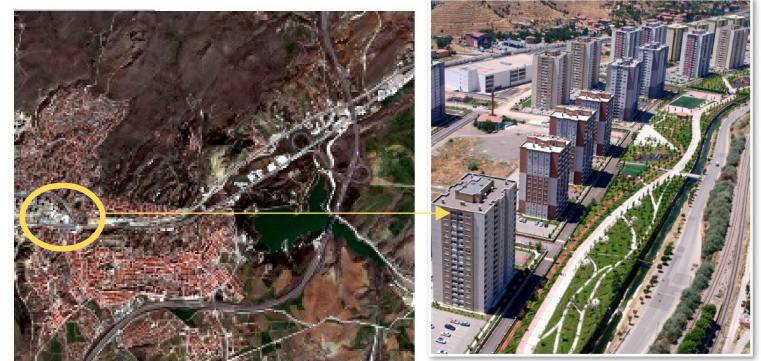
Figure 19. A part of urban transformation project within the study area [91].